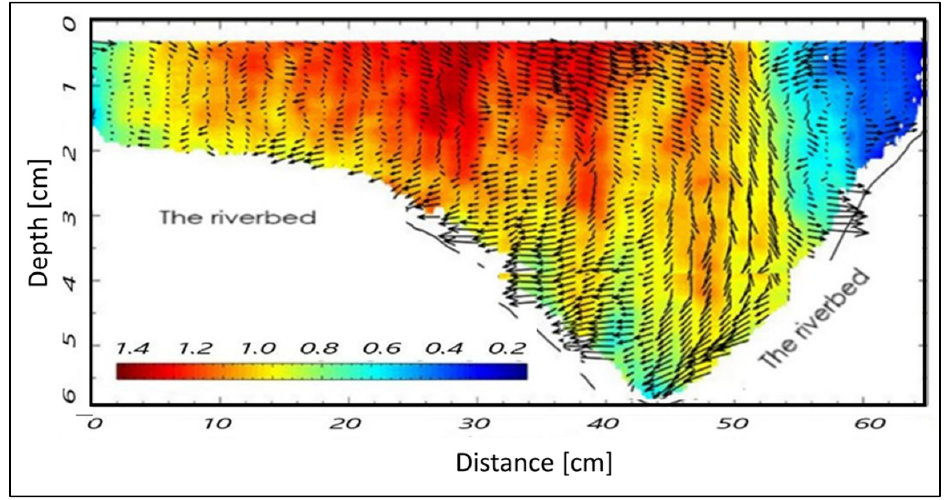
Figure 14. Detection of the riverbed and wave movements using Doppler processing for cross-sec- tion B1.